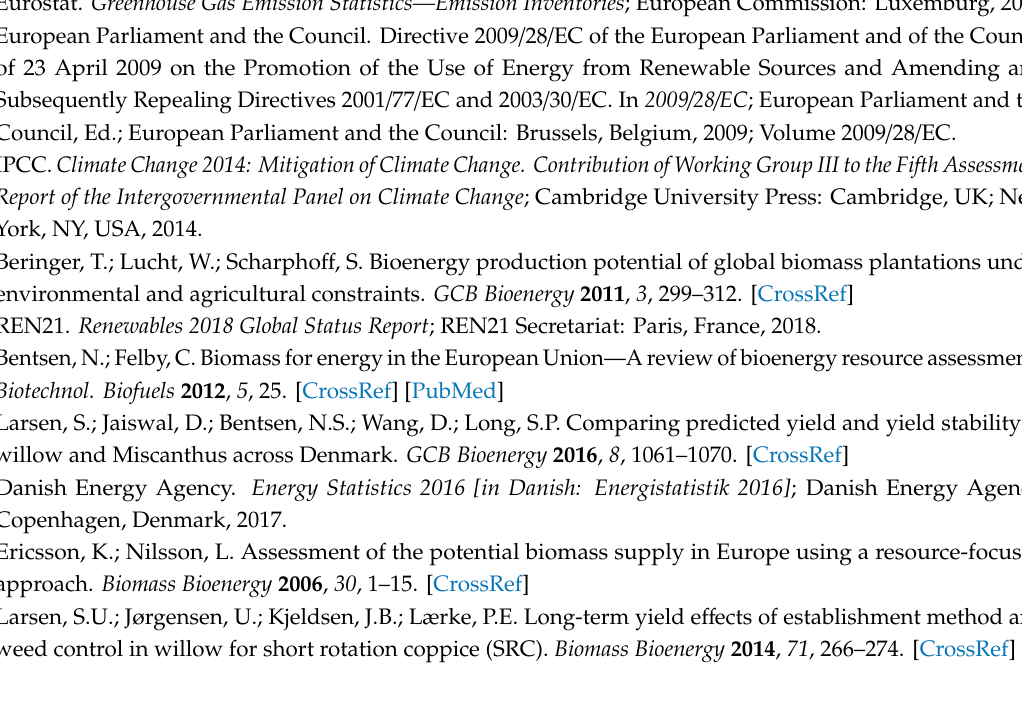
Further information and data on species productivity (Table S1: Reported Silver grass yields, Table S2: Reported willow yields, Table S3: Reported poplar yields and Table S4: Results of literature research and projection of productivity and Figure S1: Productivity of long rotation tree species across sites), energy yield (Figure S2: Applied utilization model for poplar and long-rotation forestry species and Figure S3: Range of reported Lower Heating Values (LHV) from di ff erent sources. Data sources and Table S5: Energy yields of studied species), carbon storage (Table S6: References used to quantify carbon in deadwood and soil, Table S7: Amount of carbon stored in di ff erent pools and the total carbon stock of species, reported in t C ha − 1 . and Figure S4: Total carbon stocks in relation to totally saved emission), fossil carbon displacement (Table S8: Life cycle inventory and assumptions on substitution, Table S9: Assumed production chain emission rates and values for fuels and Figure S4), nutrient balance (Figure S5: Minimum Nitrogen Requirement of species for di ff erent energy yields indicating the Nitrogen Use E ffi ciency by slope of the fitted line), biodiversity (Table S10: Factors considered in the assessment of habitat biodiversity, Table S11: Habitat biodiversity scores of the selected species and Table S12: Total biodiversity scores on all three levels and conservation potential), land use intensity (Figure S6: Land Use Intensity (LUI) of species in ha TJ − 1 ), recreation (Table S13: Recreation scores for species at di ff erent phases of development), and aesthetics (Table S14: Visual impact scoring based on selected factors at eye-horizon level Table S15: Definition of the assessed landscape types by their composition Table S16: Visual e ff ect on landscape Table S17: Summary and result of aesthetics